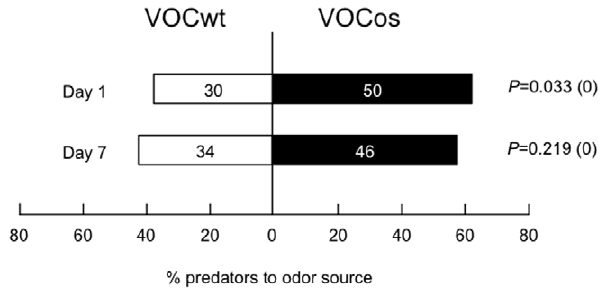
Figure 6. Plant-plant-plant communications for indirect de- fenses. VOCos-receiver or VOCwt-receiver lima bean plants were placed 30 cm apart from four emitter tobacco plants (NtOS2 or WT plants) in a greenhouse for 7 days. The VOCos-receiver or VOCwt- receiver plant was subsequently treated with T. urticae , and uninfested plants were placed 30 cm apart from the VOCos-receiver or VOCwt- receiver plants for 1 or 7 days. The second receiver was subsequently exposed to T. urticae for 1